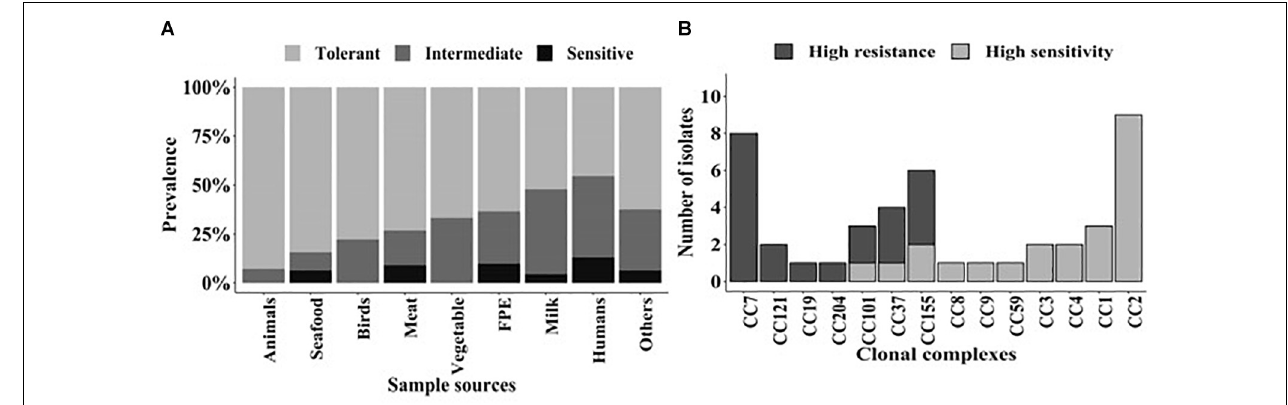
FIGURE 4 | (A) Distribution of the 356 L. monocytogenes field strains classified into the resistant ( − 2.4% ≤ (cid:49) PAUC ≤ 38.2%), intermediate (38.7% ≤ (cid:49) PAUC ≤ 70.7%), and sensitive (74.7% ≤ (cid:49) PAUC ≤ 100%) nisin response phenotypic categories based on sample sources. Strains were assigned into the three nisin response phenotypic categories based on Non-Parametric Maximum Likelihood Estimation models. (B) Distribution of the MLST CCs detected among the high nisin resistance ( (cid:49) PAUC < 10%) and sensitivity ( (cid:49) PAUC > 90%) category strains corresponding to the upper (resistant) and lower (sensitive) 10% of the (cid:49) PAUC distribution, respectively.